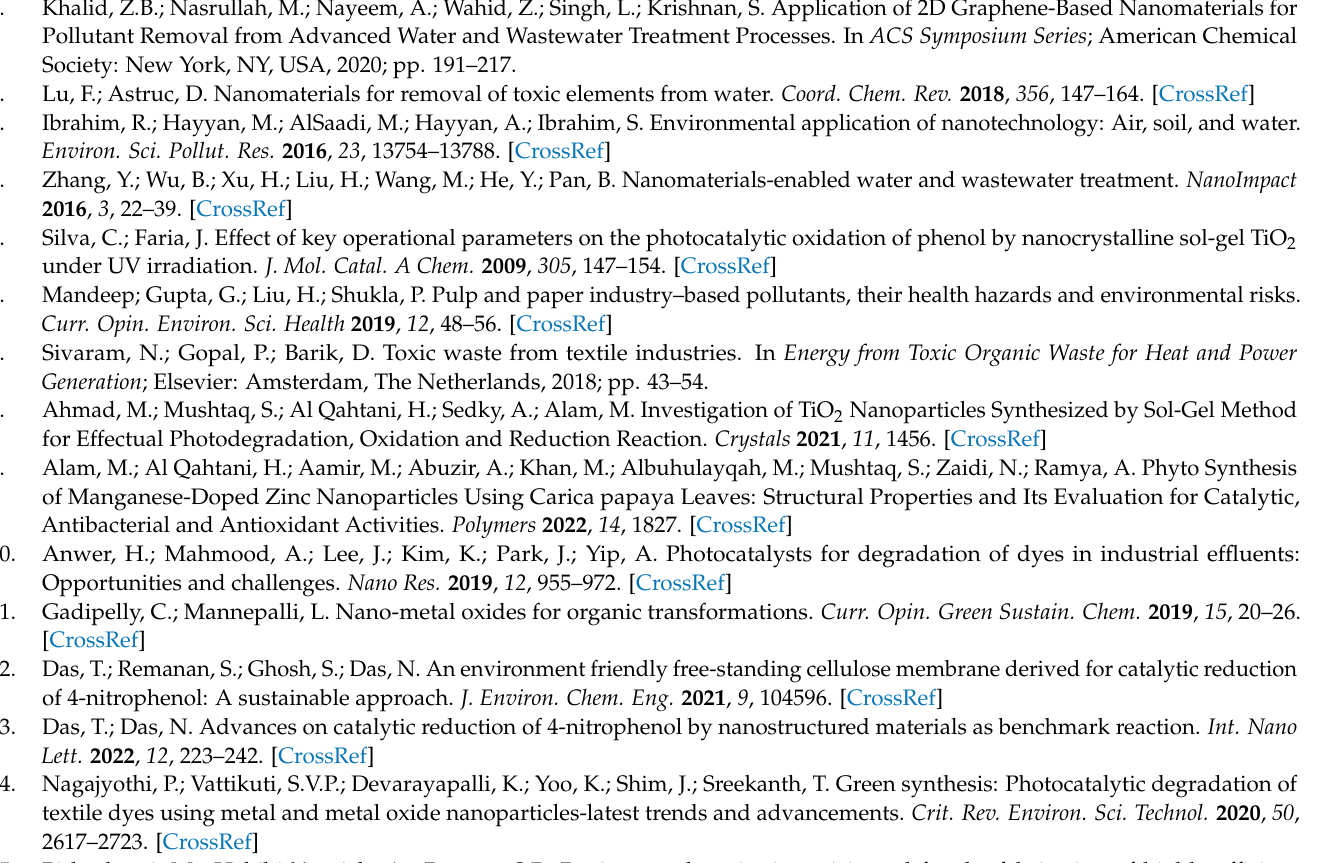
(A), UV–visible absorbance spectra of GO and rGO suspensions in ethanol (B), and photographs of powder and aqueous suspension (before drying) of GO (C) and rGO (D); text description of Figure S1; Figure S2: (A) EIS Nyquist plots of (rGO-ZnO)/CuO NCs, CuO-ZnO NCs, and ZnO NPs; Mott–Schottky plots of (B) ZnO NRs, (C) CuO-ZnO NCs, and (D) (rGO-ZnO)/CuO NCs vs.